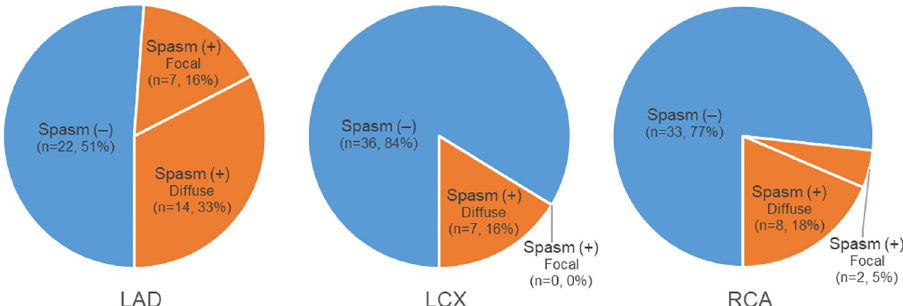
Fig 4. Per vessel analysis of spasm type for coronary spasm on CCTA. A total of 43 patients (129 vessels) were analyzed based on their spasm types. In LAD, LCX, and RCA, 14 (33%), 7 (16%), and 8 (18%) vessels showed the diffuse type, while the corresponding values for the focal type were 7 (16%), 0 (0%), and 2 (5%) vessels. LAD, left anterior descending artery; LCX, left circumflex artery; RCA, right coronary artery; Spasm (-), patients without vessels showing spasm; Spasm (+), patients with vessels showing spasm; Focal (type), significant focal stenosis without definite plaques; Diffuse (type), diffuse small diameter ( < 2 mm) with serrated margin and loss of diameter tapering.